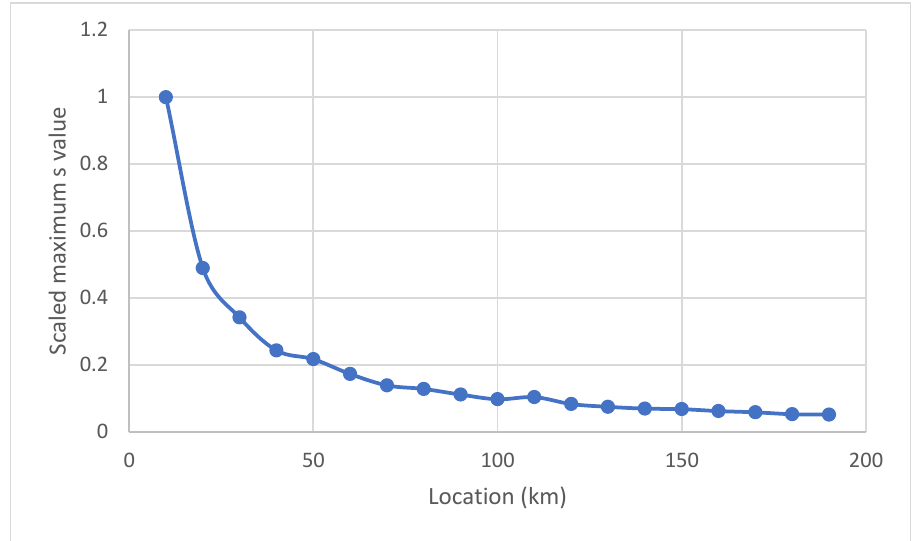
Figure 8. The best fitting curve at 19 fault locations for LL-G fault using scaled maximum singular value.